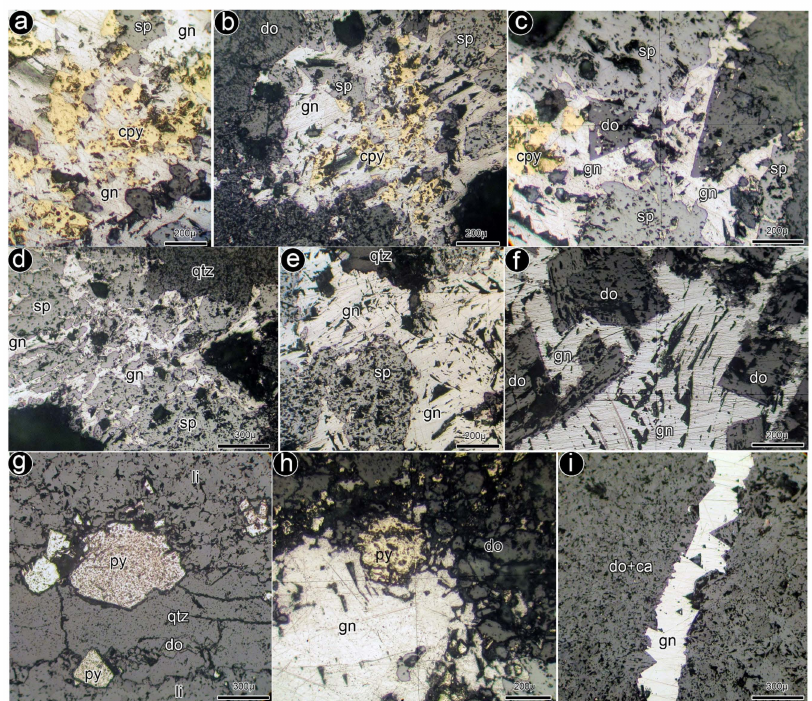
Figure 10. Microscopic photographs of complex replacement textures between sulfide minerals in replacement sulfide mineralization and dolomitized limestone. ( a – f ) Replacement of hydrother- mal dolomite and chalcopyrite with galena and sphalerite. In addition, galena was replaced with sphalerite. ( g ) Quartz (qtz) and dolomite (do) veins, associated with coarse-grained pyrite (py). ( h ) Replacement of pyrite with galena. ( i ) Galena veinlet in dolomite and calcite matrix. Hydrothermal alteration in the Ab-Bid deposit mainly consists of dolomitization, silicification, host-rock dissolution, and brecciation in sulfide ore veins and the lateral ore zones (Figure 11). Hydrothermal dolomite occurs as a replacement of the host carbonates and as cement in brecciated rocks and open-space fill (Figure 11a–c). Calcite is common in some veins and is associated with dolomite. Another common alteration associated with LOZs in the Ab-Bid deposit is dissolution and hydrothermal brecciation of the carbonate host rocks. In addition, there are some silicified patches in both COZs and LOZs that contain high-grade sulfide ore (Figure